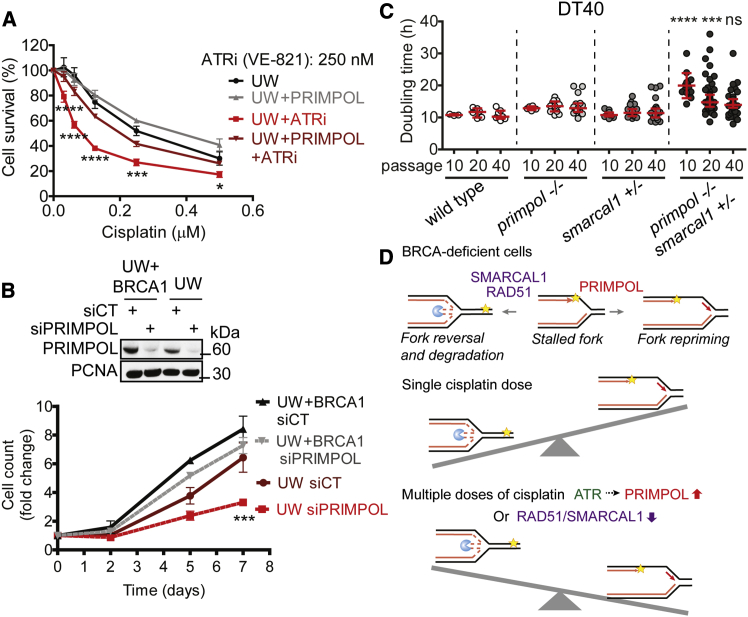
Impact of PRIMPOL on Cell Survival(A) Cell survival of UW and UW+PRIMPOL cells upon 6 days of chronic treatment with ATR inhibitor (ATRi, VE-821, 250 nM) and the indicated doses of cisplatin. Means ± SEM (n = 3). Statistics: two-way ANOVA followed by Bonferroni test comparing UW+ATRi versus UW+PRIMPOL+ATRi. ∗p < 0.05, ∗∗∗p < 0.001, ∗∗∗∗p < 0.0001.(B) Expression of PRIMPOL after siRNA (siPRIMPOL) in UW+BRCA1 and UW cells (top). Cell count in PRIMPOL-depleted UW+BRCA1 and UW cells. Means ± SEM (n = 3) (bottom). Statistics: two-way ANOVA followed by Bonferroni test comparing UW siCT versus UW siPRIMPOL. ∗∗∗p < 0.001.(C) Doubling time of DT40 cell mutants over the course of approximately 40 passages post-transfection with the smarcal1 targeting construct. Each circle represents an individual measurement of doubling time derived from three independent experiments, repeated in duplicate and on multiple independently derived clones (two primpol −/−; three smarcal1 +/−; and five primpol −/− smarcal1 +/−). Means and SD plotted as line and whiskers. Statistics: Kruskal-Wallis test for difference between smarcal1 +/− and primpol −/− smarcal1 +/−. ns, non-significant, ∗∗∗p < 0.001, ∗∗∗∗p < 0.0001.(D) Proposed model. Fork repriming and reversal are two alternative mechanisms by which cells deal with cisplatin-induced DNA lesions (top). Upon treatment with a single cisplatin dose, fork reversal is the most frequent event. However, reversed forks are targeted by nucleases in a BRCA-deficient background leading to nascent DNA degradation (middle). Multiple treatments with cisplatin lead to an ATR-dependent upregulation of PRIMPOL, shifting the balance toward repriming events while suppressing fork reversal. Alternatively, depletion of fork reversal factors, such as RAD51 and SMARCAL1, also favors PRIMPOL-dependent repriming in both BRCA-deficient and -proficient cells (bottom).See also Figures S6 and S7.